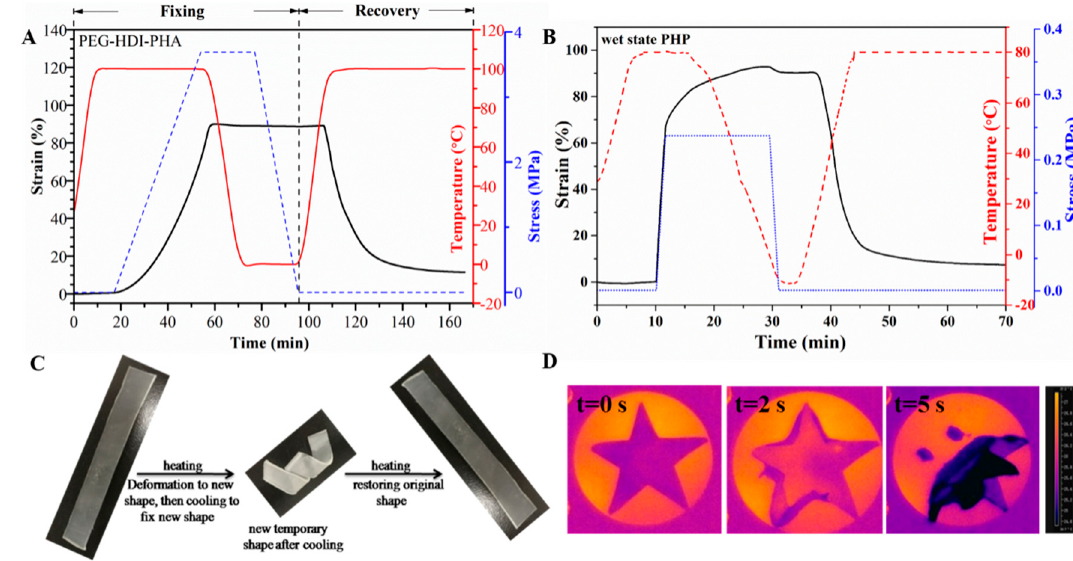
Figure 5. Dual-shape memory cycles of samples. ( A ) PHP in dry state and ( B ) wet state. ( C ) The shape-memory e ff ect of PEG–HDI–PHA; initial state; deformed state (deformed at 80 ◦ C, and fixed at − 10 ◦ C); recovered state after being placed in 80 ◦ C bake oven for 10 min. ( D ) The shape-deformed state after being soaked in water for 5 s at the room temperature (27 ◦ C).